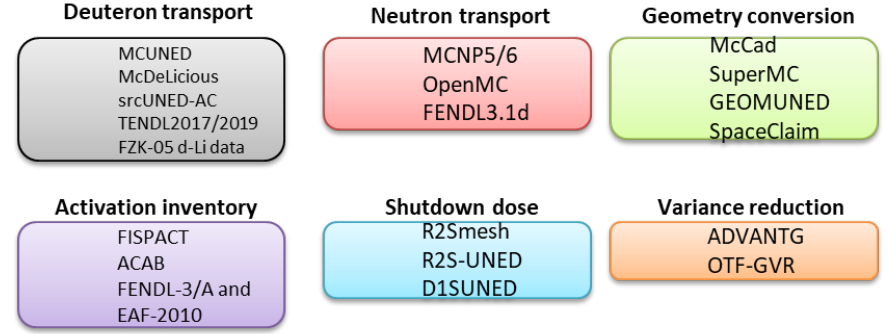
Figure 1. Summary of computational tools for neutronic analyses.